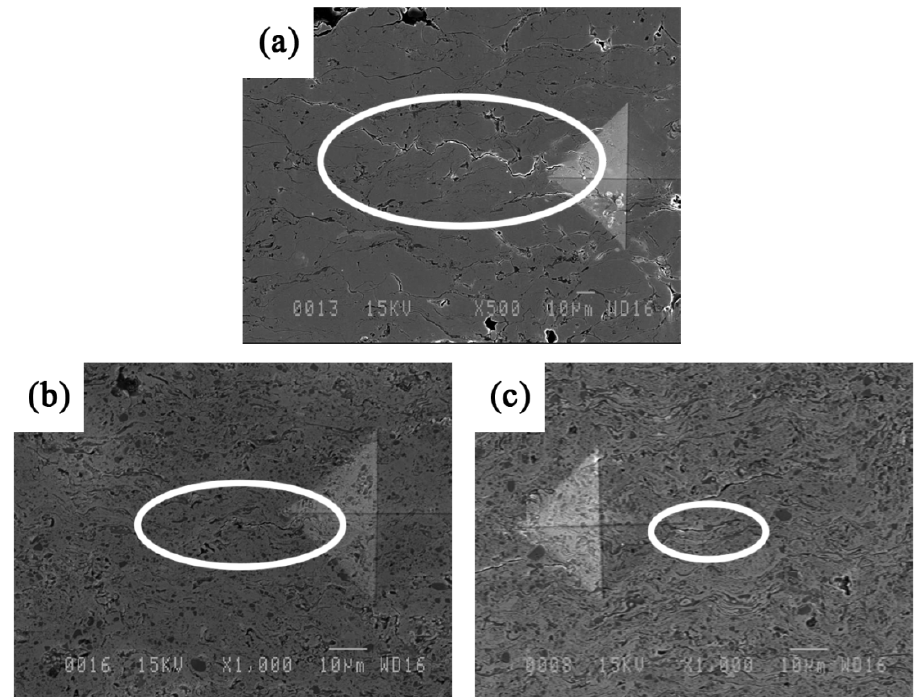
Figure 6. SEM images of Vickers indentation cracks (induced at high load of 1000 gf) on ( a ) Fe 3 Al, ( b ) Fe 3 Al ‐ 30 vol.% TiB 2 and ( c ) Fe 3 Al ‐ 50 vol.% TiB 2 coating cross sections. Crack propagation paths have been indicated by white ovals.